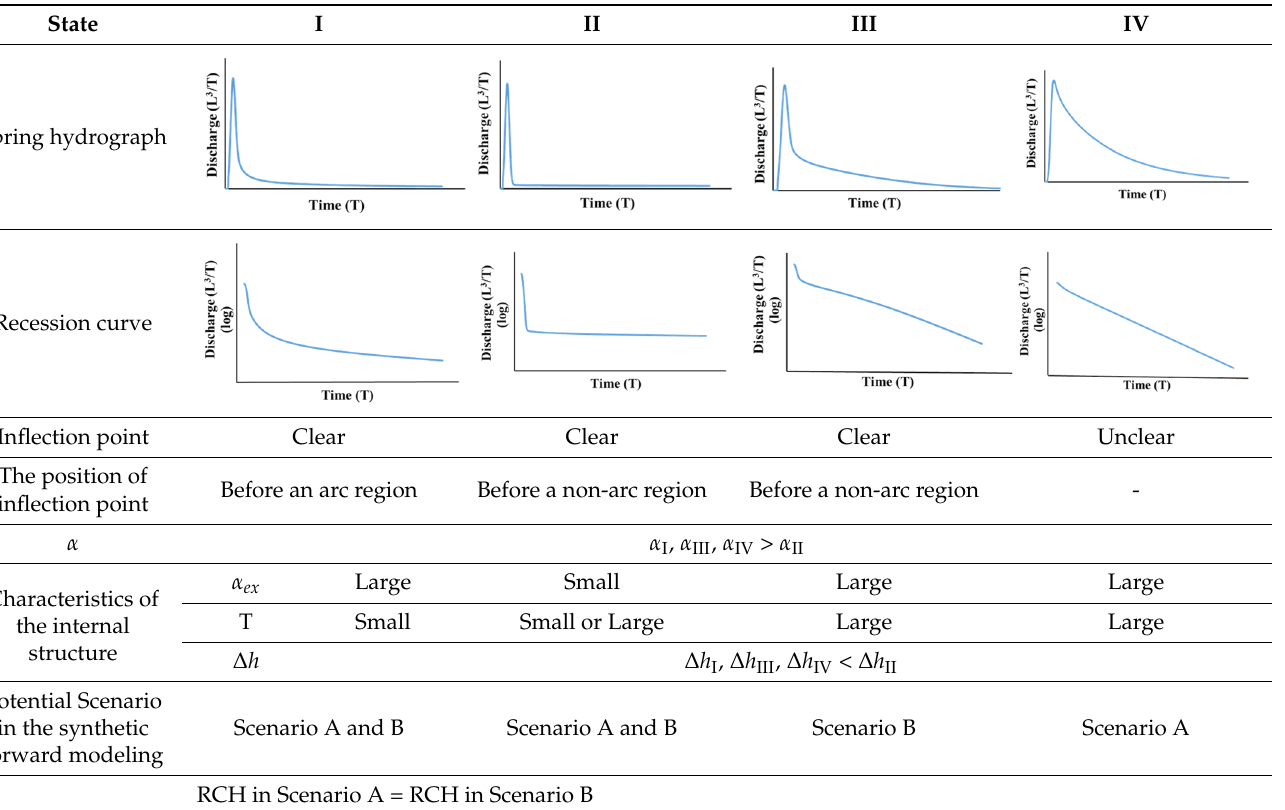
Table 2. Classification of spring hydrographs based on the mechanism of exchange flow.